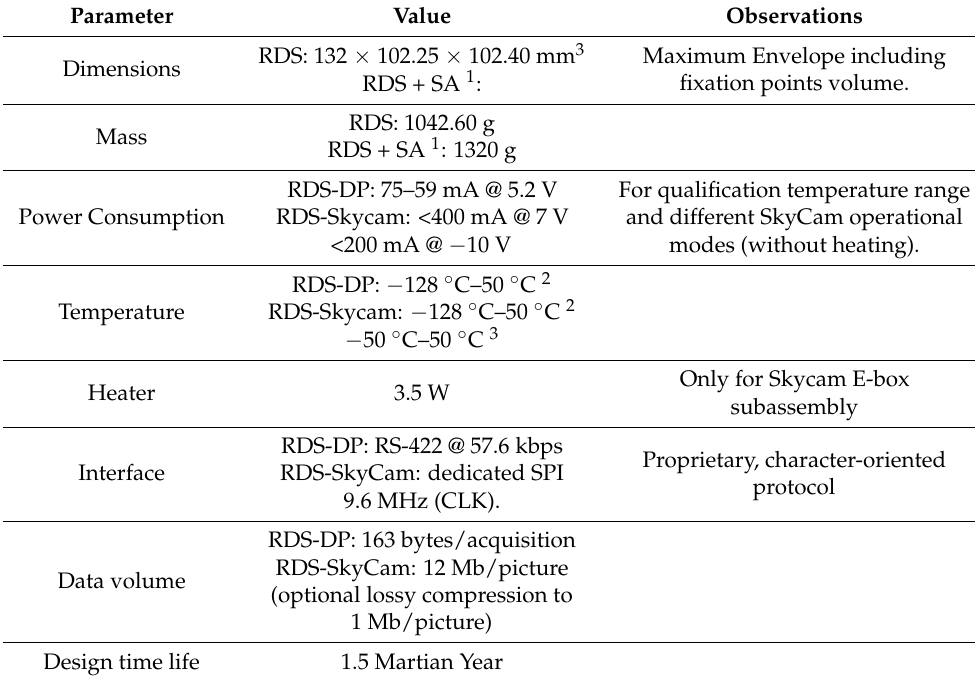
Table 1. RDS design final figures.